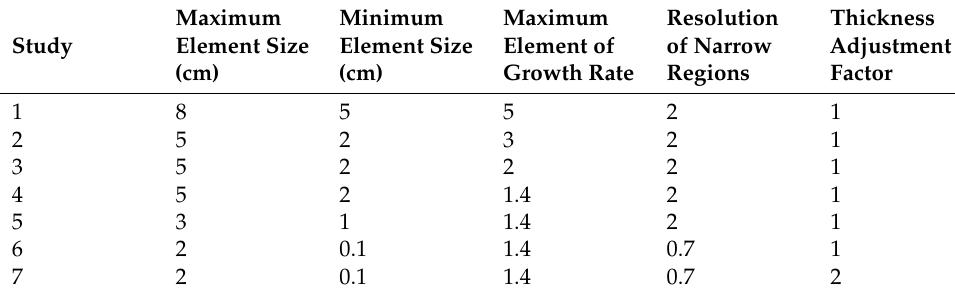
Figure 2. Design showing a good quality of structure mesh. Table 1. Parameters details of different mesh studies.